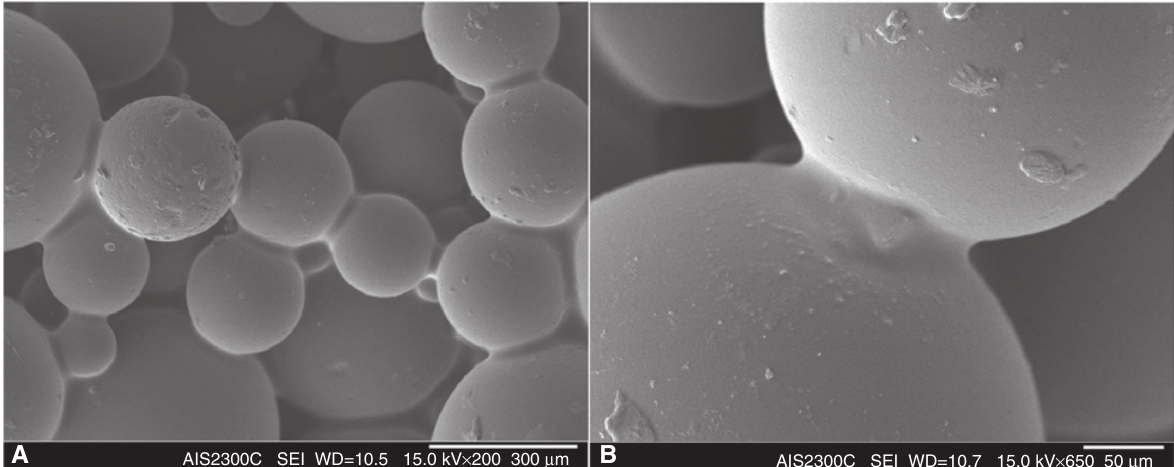
Figure 3 SEM micrographs of PPF/BG scaffolds (A and B).